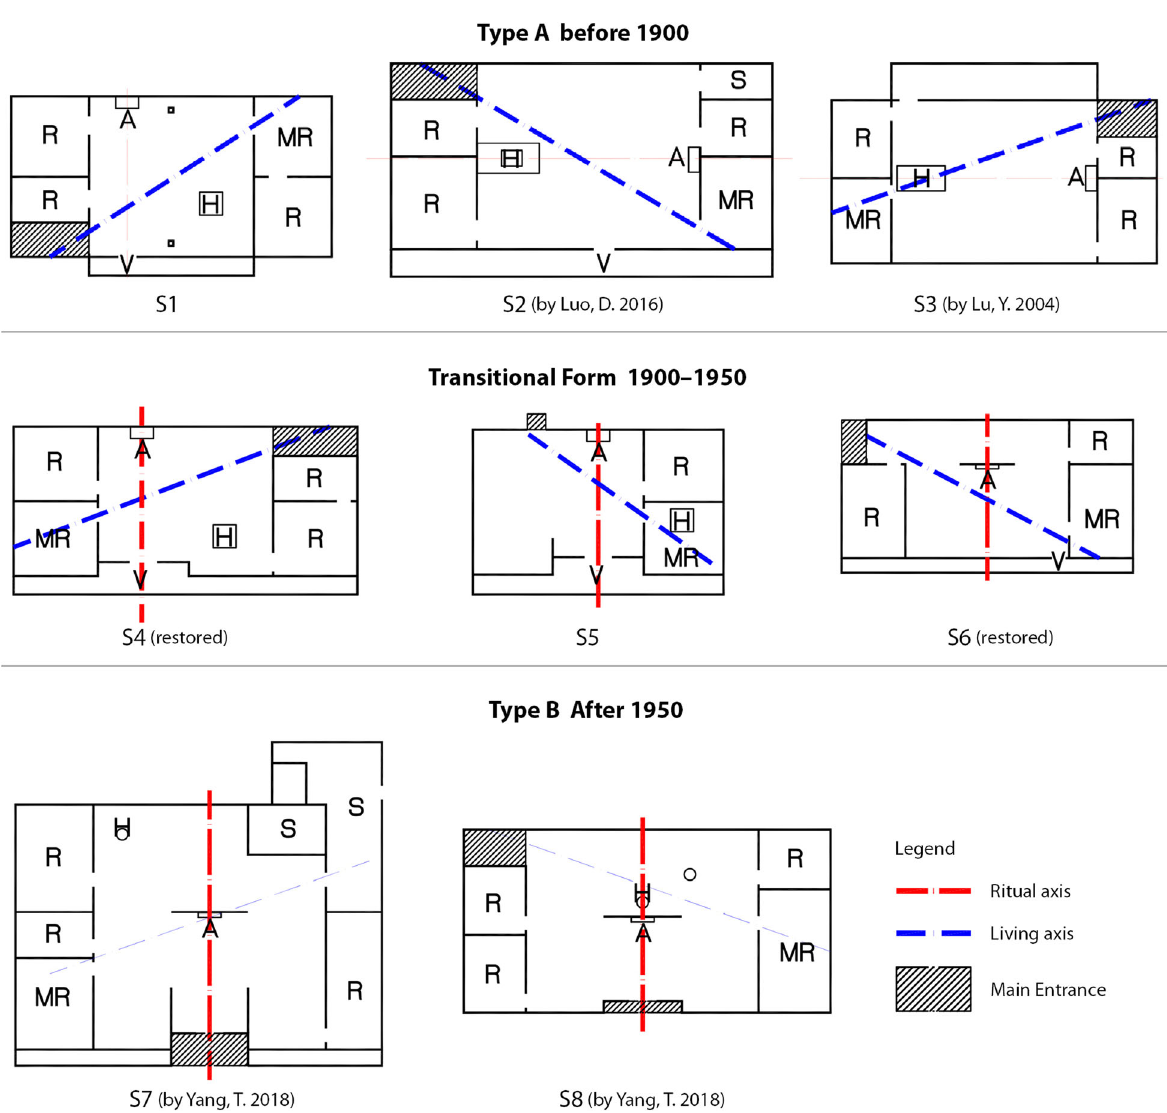
Fig. 15 Ritual and living axes are quite different between types A and B (Source: the